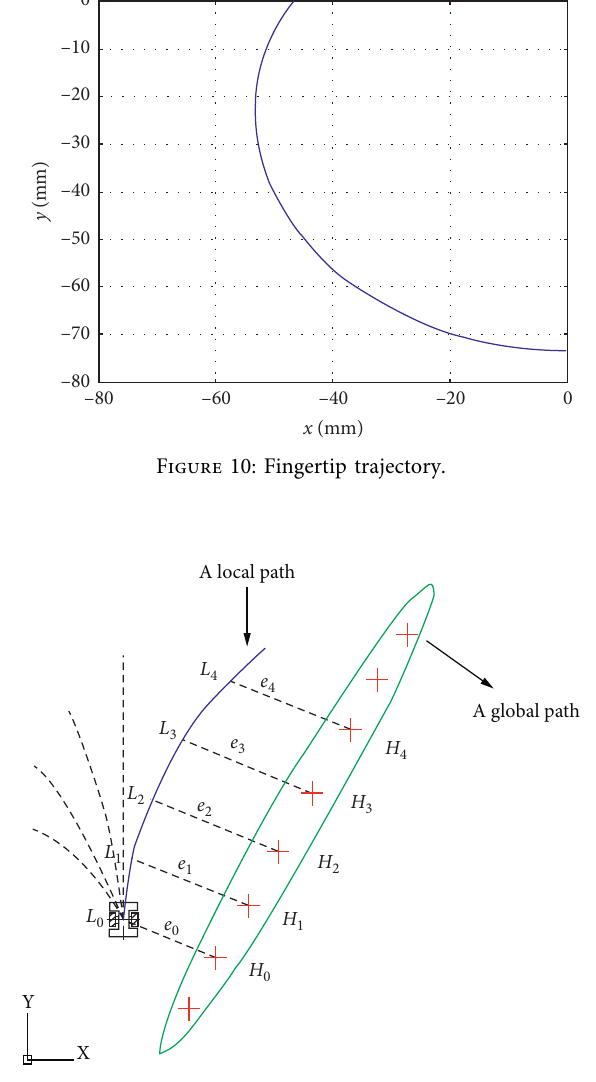
Figure 11: An error term